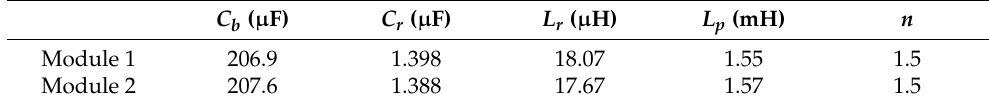
Table 3. Real circuit parameters of the two